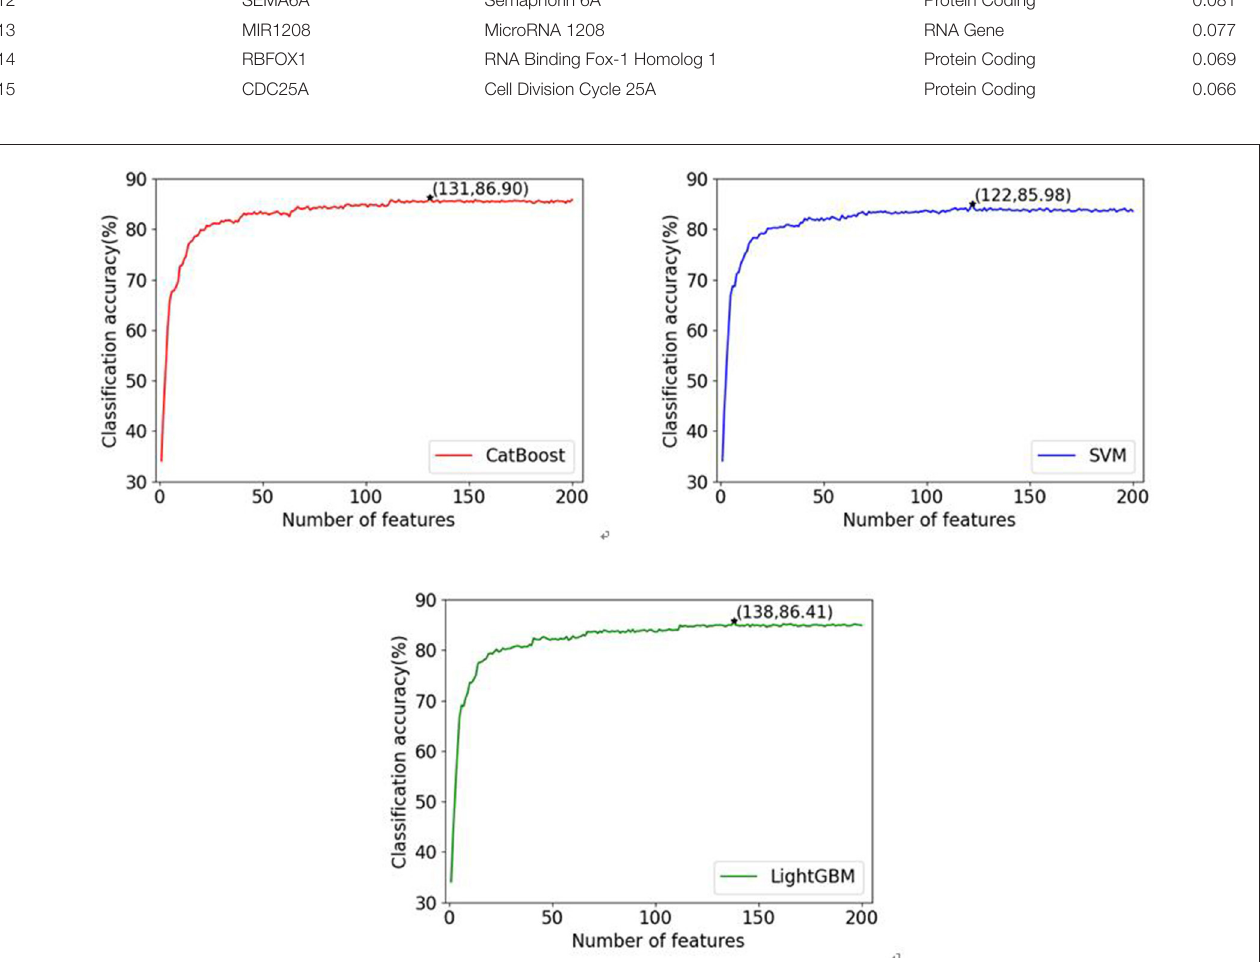
FIGURE 2 | Classification accuracies of three classifiers (CatBoost, LightGBM and SVM) with different numbers of features during the IFS procedure. The top 200 feature genes are selected by CRIA method.